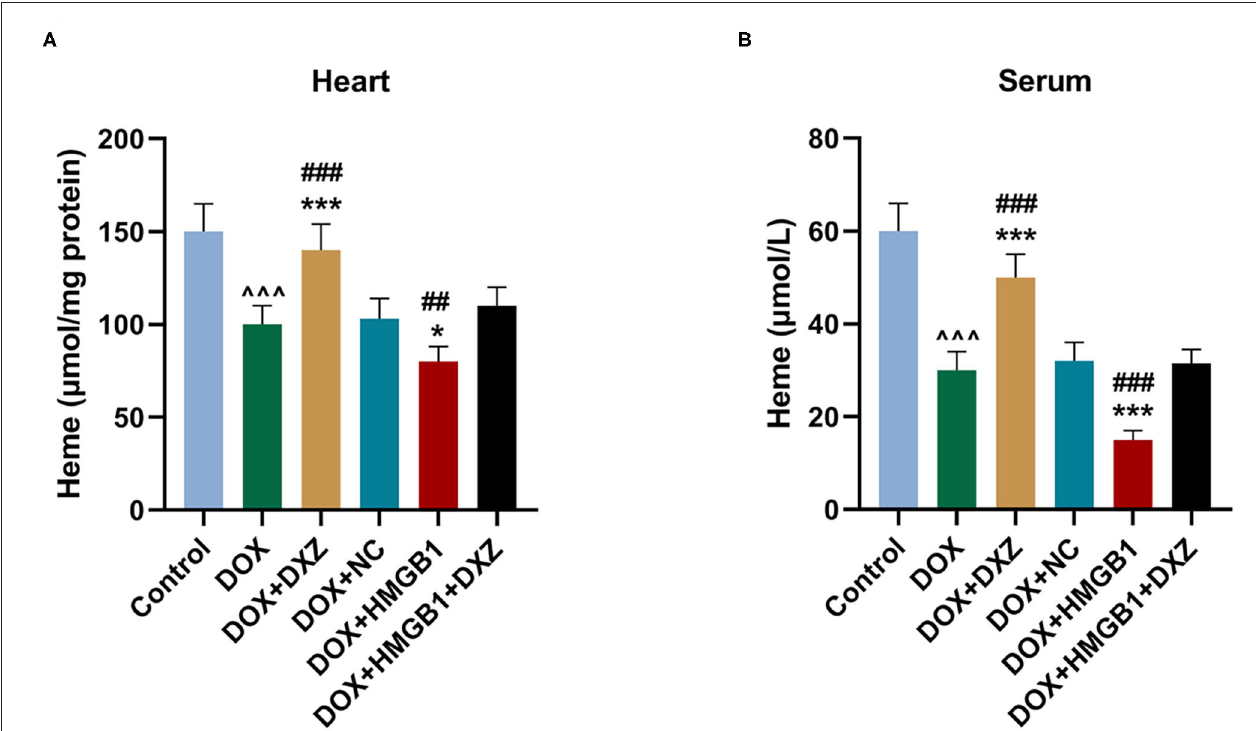
FIGURE 4 | The levels of heme in the heart and serum of rats. (A,B) The level of heme in the heart and serum of rats from different groups after the treatment for 4 days was detected by a commercial kit. Ten rats were used in each group. ∧∧∧ P < 0.001 vs. control. * P < 0.05, *** P < 0.001 vs. DOX. ## P < 0.01, ### P < 0.001 vs. DOX + HMGB1 + DXZ. Each experiment was repeated three